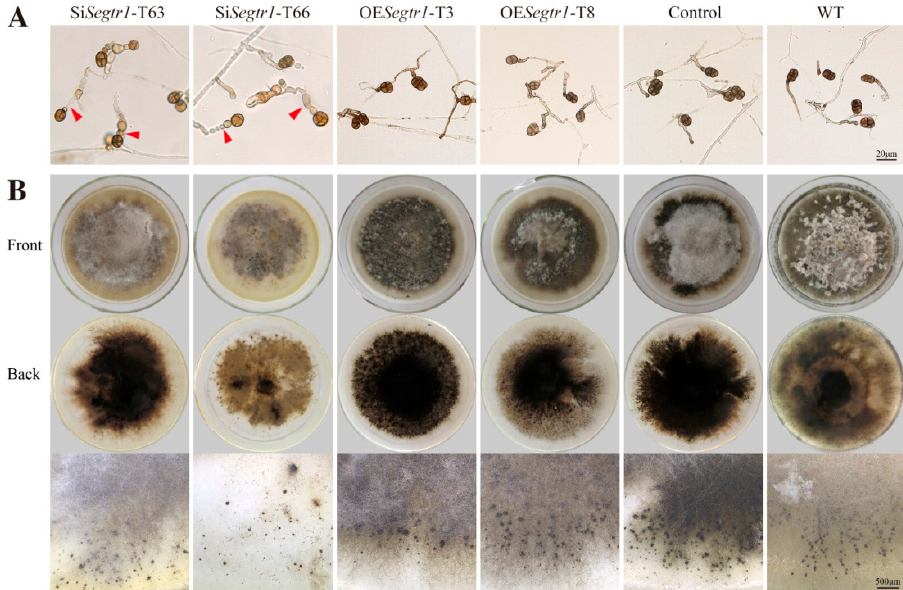
Figure 3. SeGtr1 plays a role in asexual development, but the sexual activity was unchanged. ( A ) For the microscopic investigation of conidiophores and conidia development, two silenced transformants (Si Segtr1 -T63 and Si Segtr1 -T66), two overexpression transformants (OE Segtr1 -T3 and OE Segtr1 -T8), Control and WT strains were grown on CM medium for 35 days, respectively. Control was a negative control strain. Red arrowheads indicated abnormal conidiophores. ( B ) To further observe the role of Segtr1 during the sexual development of S. eturmiunum , all transformants and WT strains were cultured on PDA medium for inducing perithecia production. At 35 days, all transformant strains produced abundant perithecia. Bar = 20 μ m and 500 μ m.